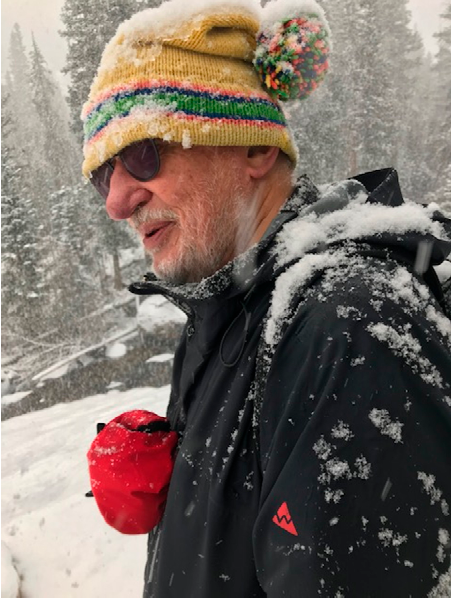
Figure 2. Josef Michl, credit from Veronica Vaida.